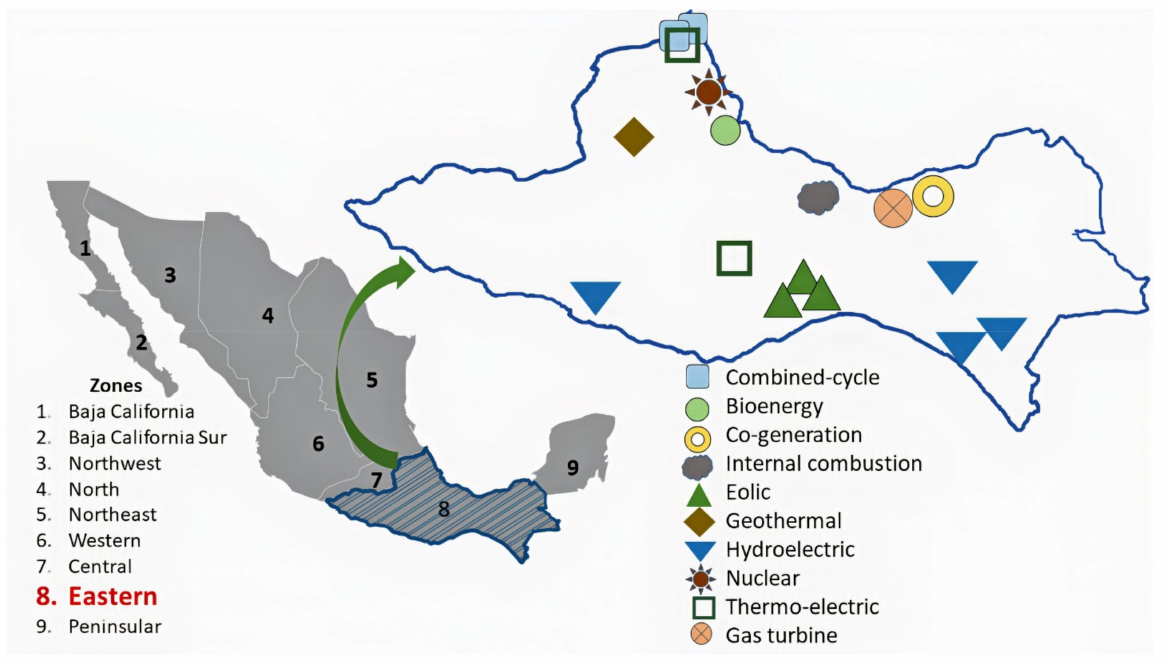
Figure 1. Mexican Electric System denoted by zones. The zone of interest is shaded (zone 8). [34]. The eastern part of Mexico has 110 generation plants, of which the primary source is hydroelectric and wind energy, as shown in Figure 2. This feature is due to its geographical location and high wind potential.